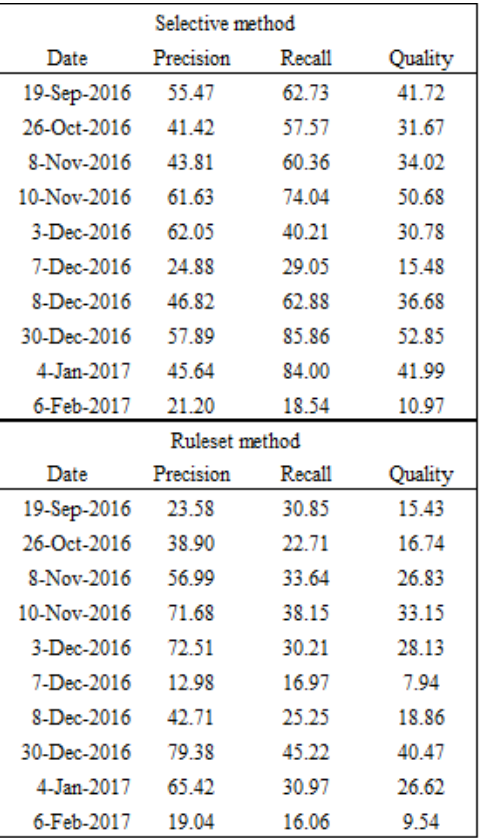
Table 2. Season 2016/17: validation results